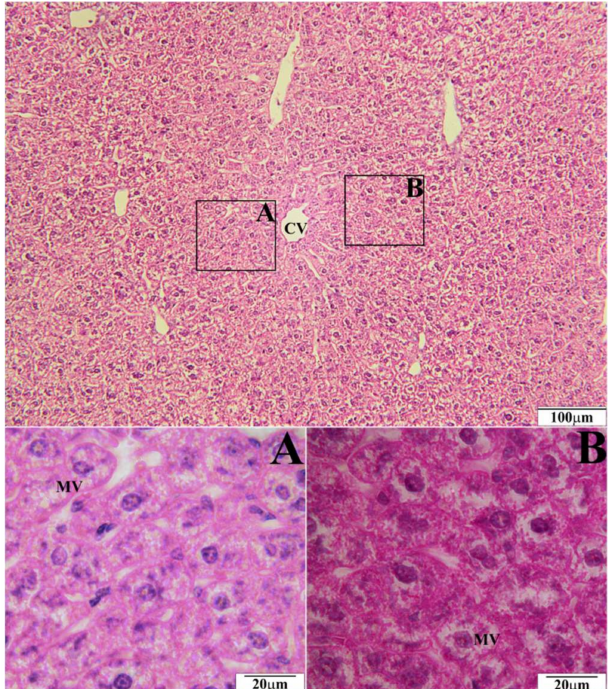
Figure 3. Representative section of the liver of C 57 BL 6 mice on a high-fat diet supplemented with EEP in the dose of 1 g/kg BM (HFD-1). Slides stained with Hematoxylin and Eosin. CV—central vein, MV—microvesicular fatty